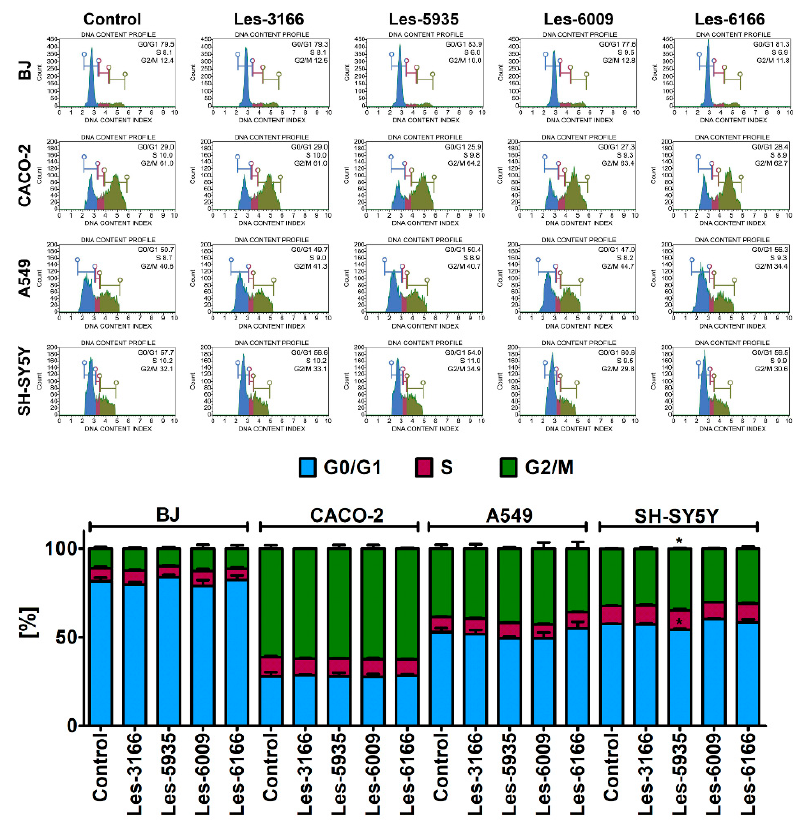
Figure 5. Cell cycle analysis after Les-3166, Les-5935, Les-6009, and Les-6166 treatments for 24 h in BJ, A549, SH-SY5Y, and CACO-2 cells. Mean values with standard deviation (error bars) where * are statistically different from the respective (vehicle-treated) control at p < 0.05 (one-way ANOVA, Tukey’s test) ( bottom ). Representative histograms are also shown ( top ).